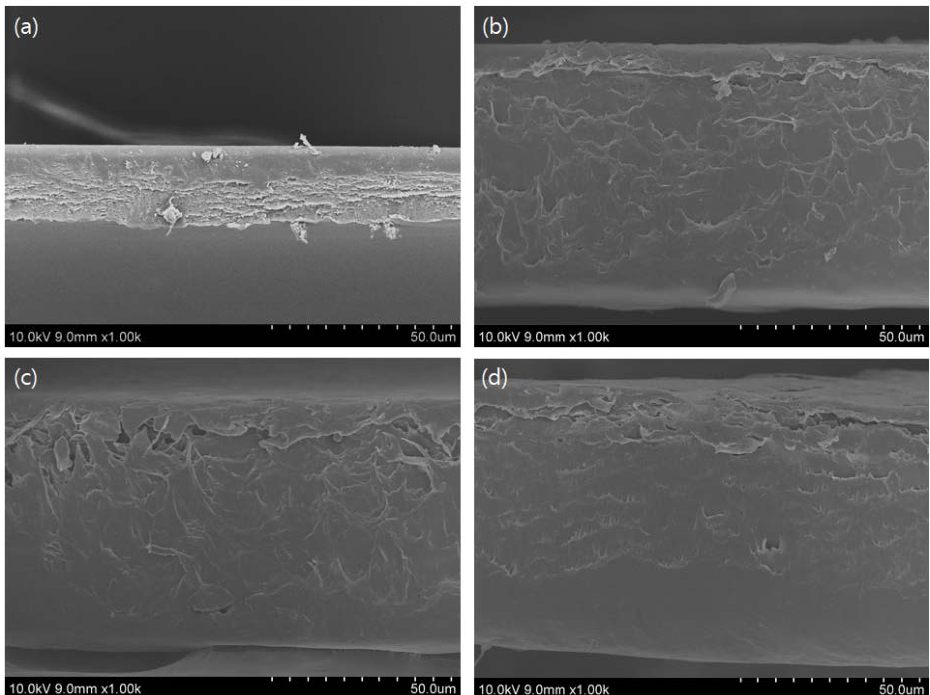
Figure 6. SEM images of composites having: ( a ) only CP, ( b ) 1:0.5 CP/PU, ( c) 1:1 CP/PU, and ( d ) 1:1 CP/PU with 10 wt% curcumin.